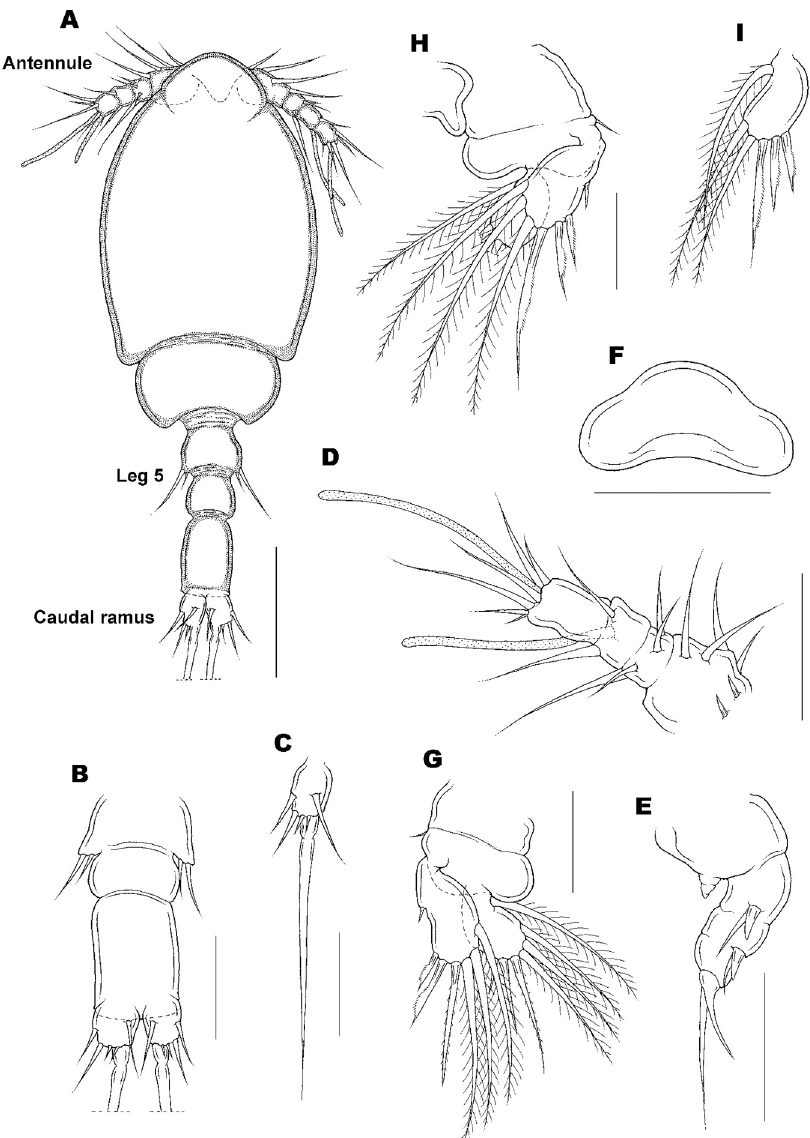
Fig 6. Copepodid stage I of Ive ptychoderae . (A) Habitus, dorsal; (B) Urosome, dorsal; (C) Caudal ramus; (D) Antennule; (E) Antenna; (F) Labrum; (G) Leg 1; (H) Leg 2; (I) Endopod of leg 2. Scale bars: A = 0.05 mm; B–I = 0.025 mm.